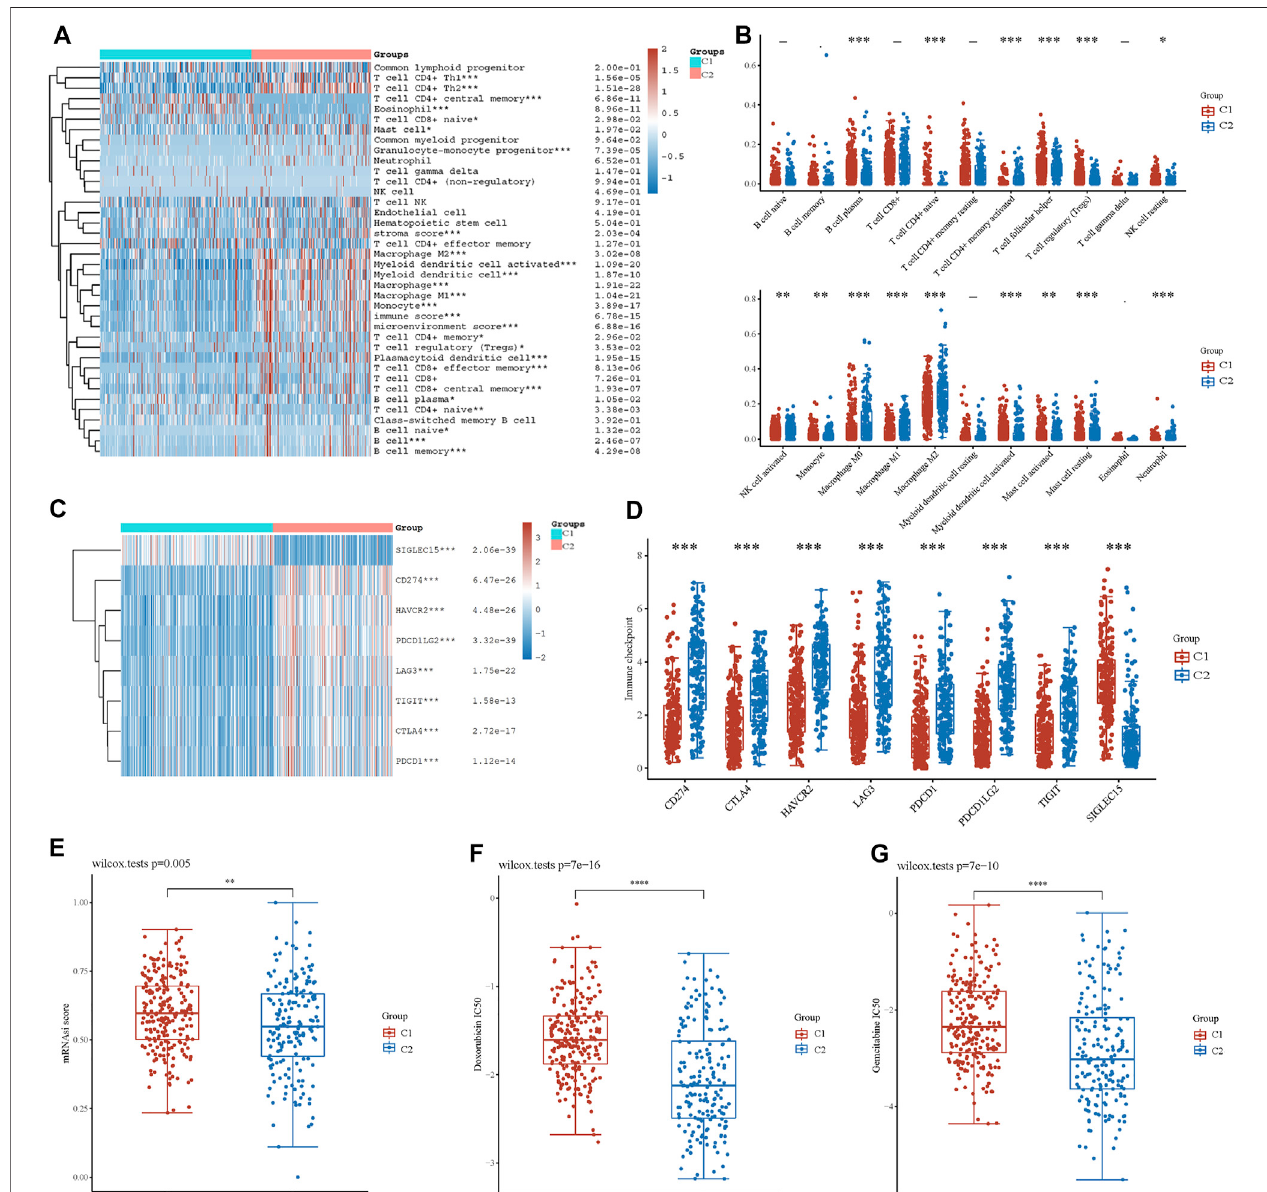
FIGURE 4 | Analysis of immune cell in fi ltration between two clusters. (A) Immune cell score heatmap by xCell algorithm. Red represents high expression/score, whereas blue represents low expression/score. (B) Boxplot of immune in fi ltration status in two clusters by the CIBERSORT algorithm. Heatmap (C) and boxplot (D) of immunecheckpoint-relatedgeneexpressionbetweentwoclusters.Cancerstemcellscores (E) andchemotherapyresistancetodoxorubicin (F) andgemcitabine (G) of the two clusters. * p < 0.05, ** p < 0.01, *** p < 0.001.